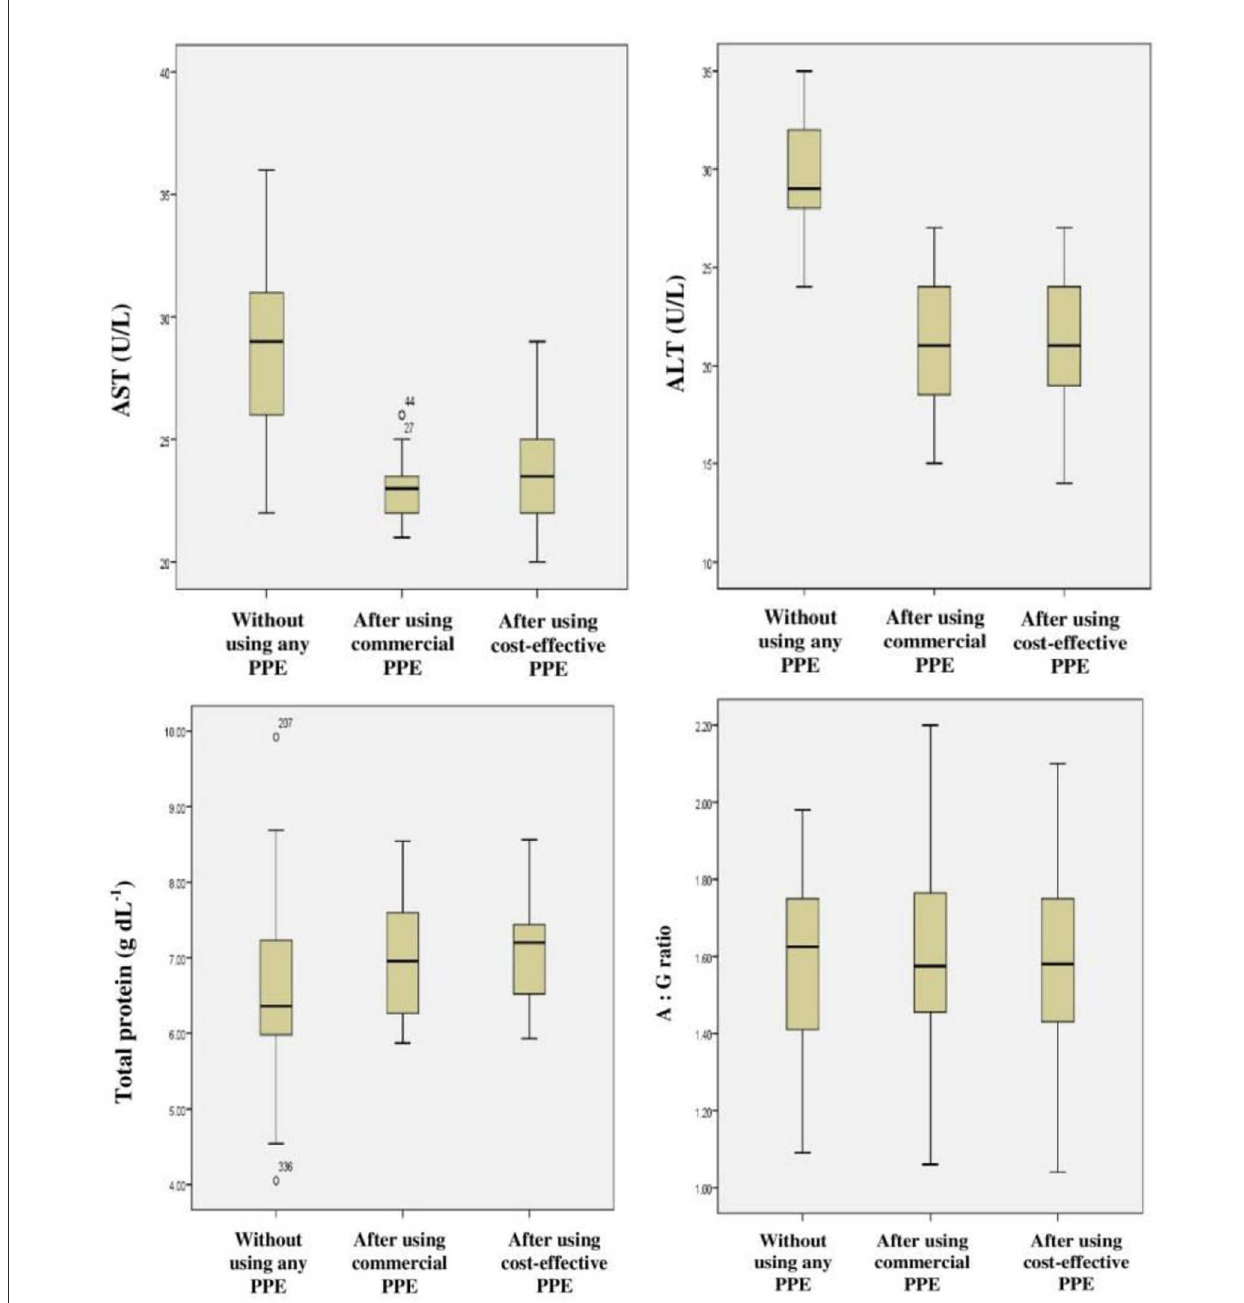
FIGURE8 Frequency distribution for liver function tests among farm-workers not using and after their use of